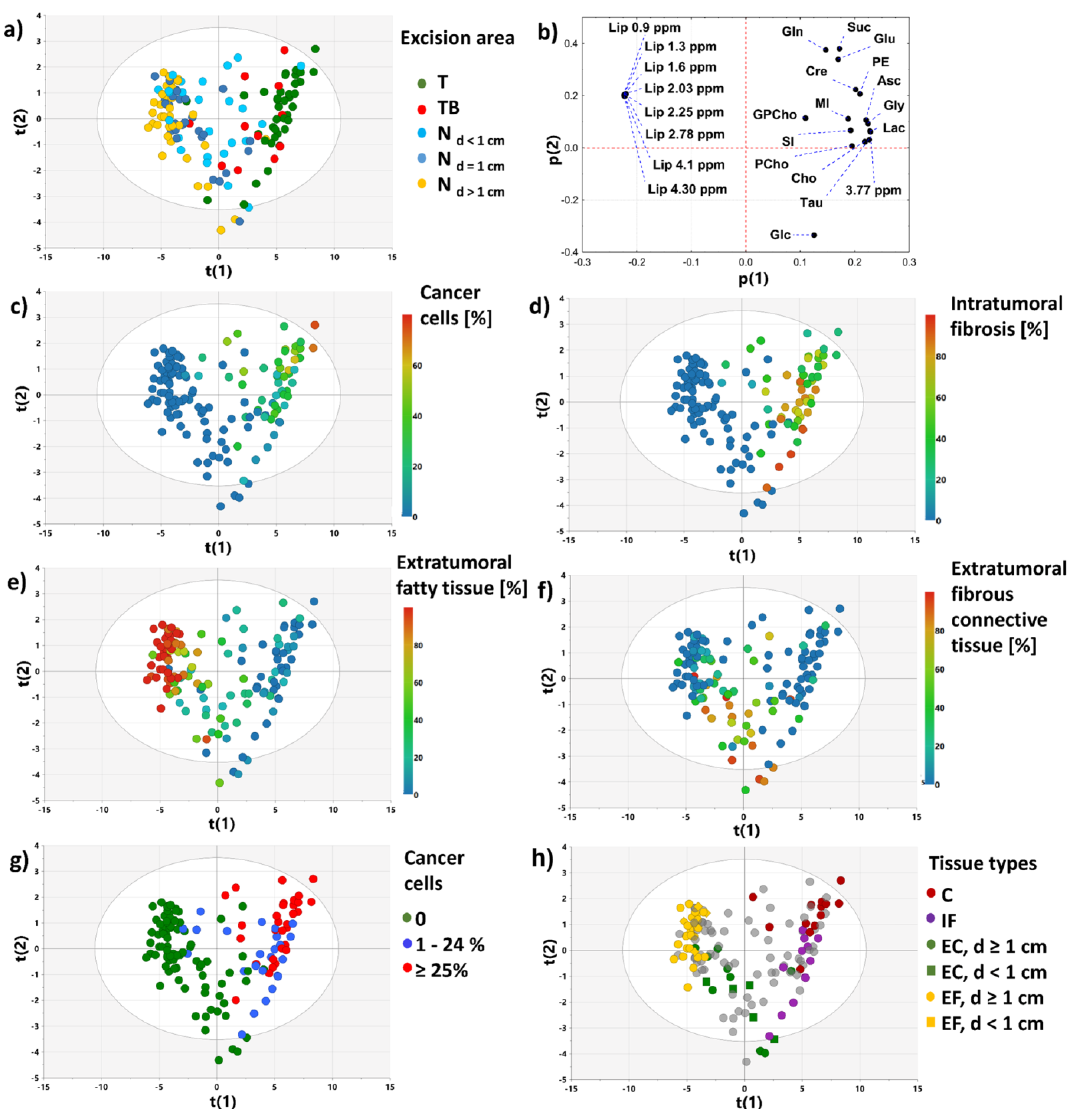
Figure 3. PCA model 1: the scores plot colored according to the excision area ( a ), the loadings plot ( b ), the scores plot colored according to the content of: cancer cells ( c ), intratumoral fibrosis ( d ), extratumoral fatty tissue ( e ), extratumoral fibrous connective tissue ( f ). The scores plot presenting the distribution of the non-transformed tissue samples, the malignant samples characterized by the cancer cell content below 25% and the malignant samples characterized by the cancer cell content greater than or equal to 25% ( g ). The scores plot presenting the distribution of the samples of specific tissue types (according to the criteria defined in Table 3): C–cancer; IF–intratumoral fibrosis; EC, d ≥ 1 cm–extratumoral fibrous connective tissue at a distance ≥ 1 cm from the tumor border; EC, d < 1 cm–extratumoral connective tissue at a distance <1 cm from the tumor border; EF, d ≥ 1 cm–extratumoral fatty tissue at a distance ≥ 1 cm from the tumor border; EF, d < 1 cm–extratumoral fatty tissue at a distance <1 cm from the tumor border ( h ). The scores for the i-th component are denoted as t(i), the loadings for the i-th component–as p(i). Abbreviations: Glc–glucose, Asc– ascorbate, Lac–lactate, MI–myo-inositol, PE–phosphoethanolamine, Cre–creatine, 3.77 ppm–signal corresponding to α -H group of amino acids, Gly–glycine, Tau–taurine, SI–scyllo-inositol, GPCho– glycerophosphocholine, PCho–phosphocholine, Cho–choline, Glu–glutamate, Suc–succinate, Gln– glutamine, residual lipid signals (Lip 0.9 ppm, Lip 1.3 ppm, Lip 2.03 ppm, Lip 2.78